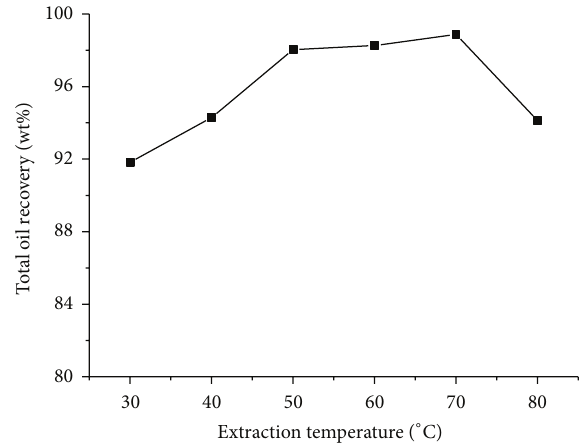
Figure 4: The effect of extraction temperature.